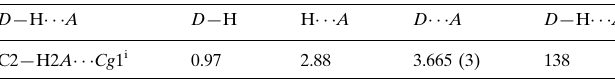
Hydrogen-bond geometry (A˚ , (cid:2)